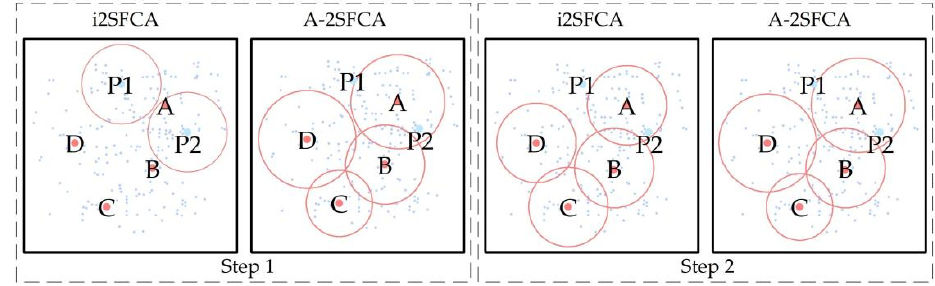
Figure 3. Comparison of i2SFCA and A-2SFCA methods for generating the catchment area.